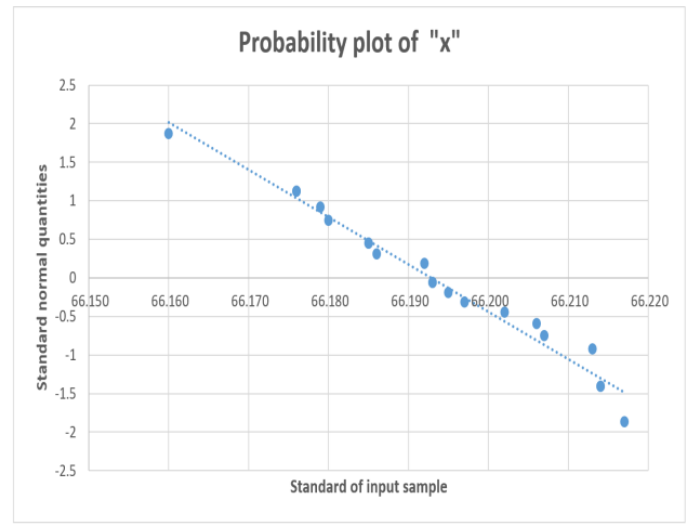
Figure 9. Normality test for “ x ” axis of sensing object.